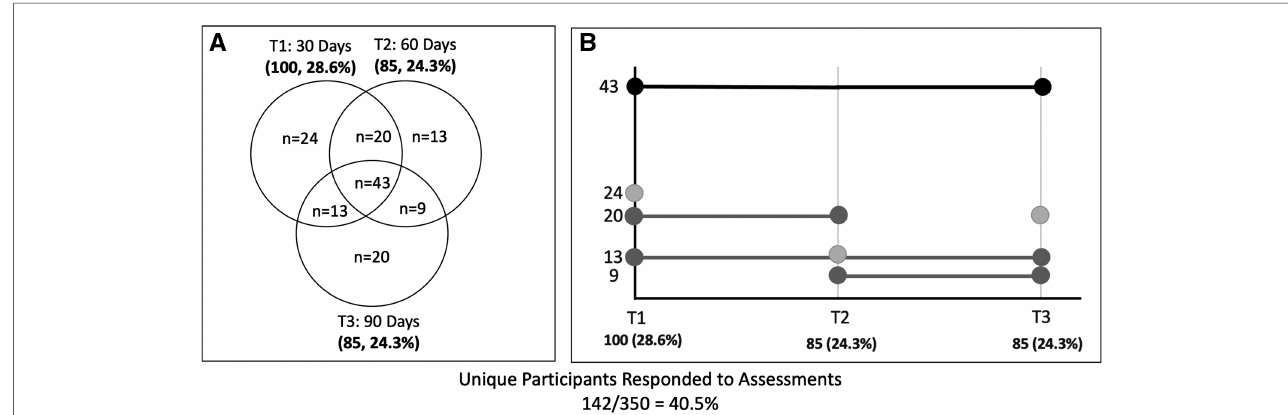
FIGURE 2 ( A ) Number of SMS-text assessment responses at different time points depicted in a Venn diagram ( N , N %). N indicates unique participant responses. For example, N =13 participants responded at 60 days poststroke, N =20 answered at both 30 and 60 days, and N =43 responded at all three study time points. ( B ) SMS-text assessment compliance over time. Shades of gray (dark to light) correspond to those that responded at all time points, those that responded at two timepoints (T 1 and T 2 , T 1 and T 3 , or T 2 and T 3 ), and those that responded at a single time point (T 1 , T 2 , or T 3 ). SMS, short message service.